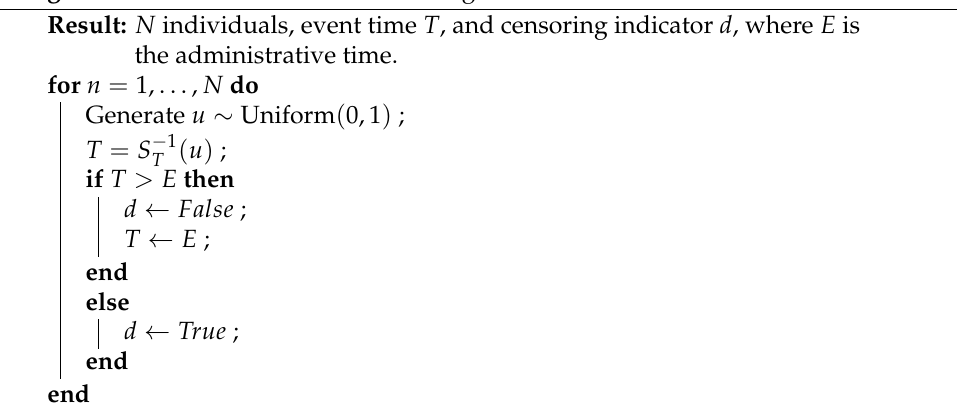
Algorithm A2: Pseudo-code of survival generative model